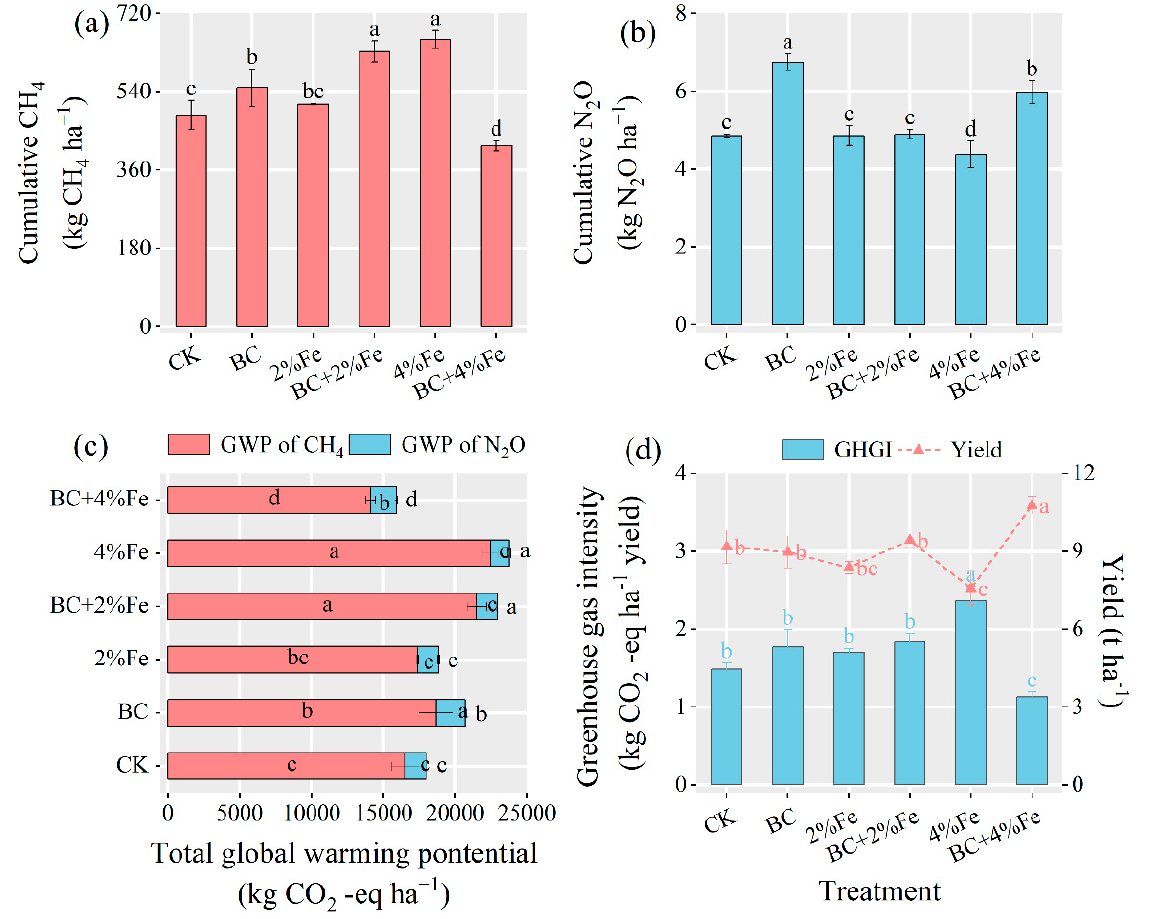
Figure 3. ( a ) Cumulative CH 4 emissions, ( b ) Cumulative N 2 O emissions, ( c ) Global warming potential ( GWP ) for different treatments, ( d ) Yield and emission intensity ( GHGI ) of different treatments. The data are presented as mean ( ± standard error). Different lowercase letters indicate significant differences between different treatments at p < 0.05.